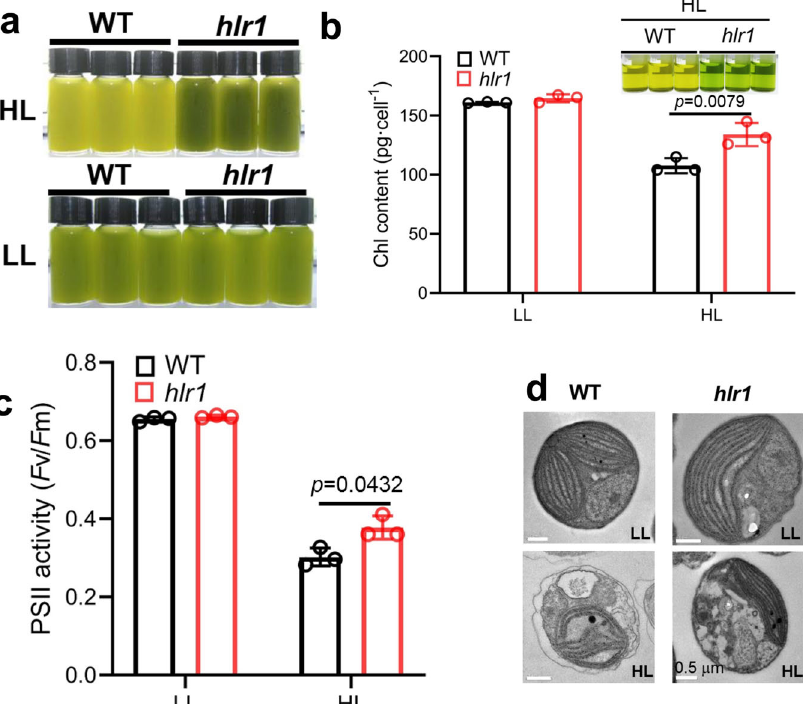
Fig. 1 The N. oceanica hlr1 mutant is tolerant to high light. a Cultures of WT and the hlr1 mutant grown in LL or HL conditions. Note the dark coloration of the hlr1 strains as compared with the pale coloration of WT under HL conditions for 8 days. b Chl quanti fi cation. The inset shows a comparison of pigment extraction of WT and the hlr1 mutants under HL conditions. c PSII photochemical ef fi ciency measurements. Algal cells in the mid-logarithmic growth phase were collected and resuspended to equal cell densities. After overnight acclimation, cells were transferred to the indicated light regime for 24h, then the maximum PSII photochemical ef fi ciency ( F v / F m ) was measured. d Transmission electron microscopy images. Bar = 0.5 μ m. LL, low light (5 µ molphotonsm − 2 s − 1 ); HL, high light (200 µ molphotonsm − 2 s − 1 ). Data are presented as the means±SD ( n = 3 for b , c ). The P values with signi fi cance are